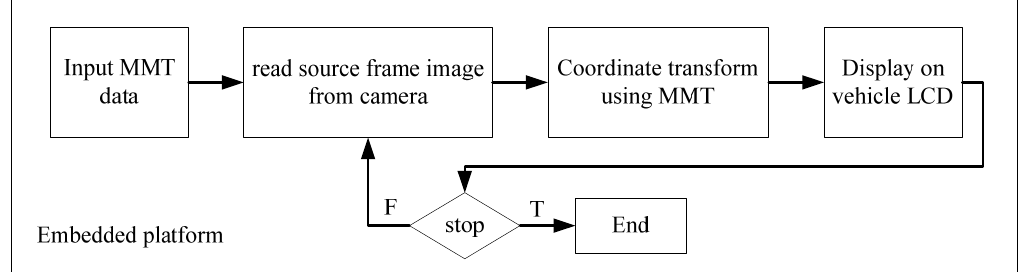
Figure 8. Processing flow of TVTM on an embedded platform with LCD screen.